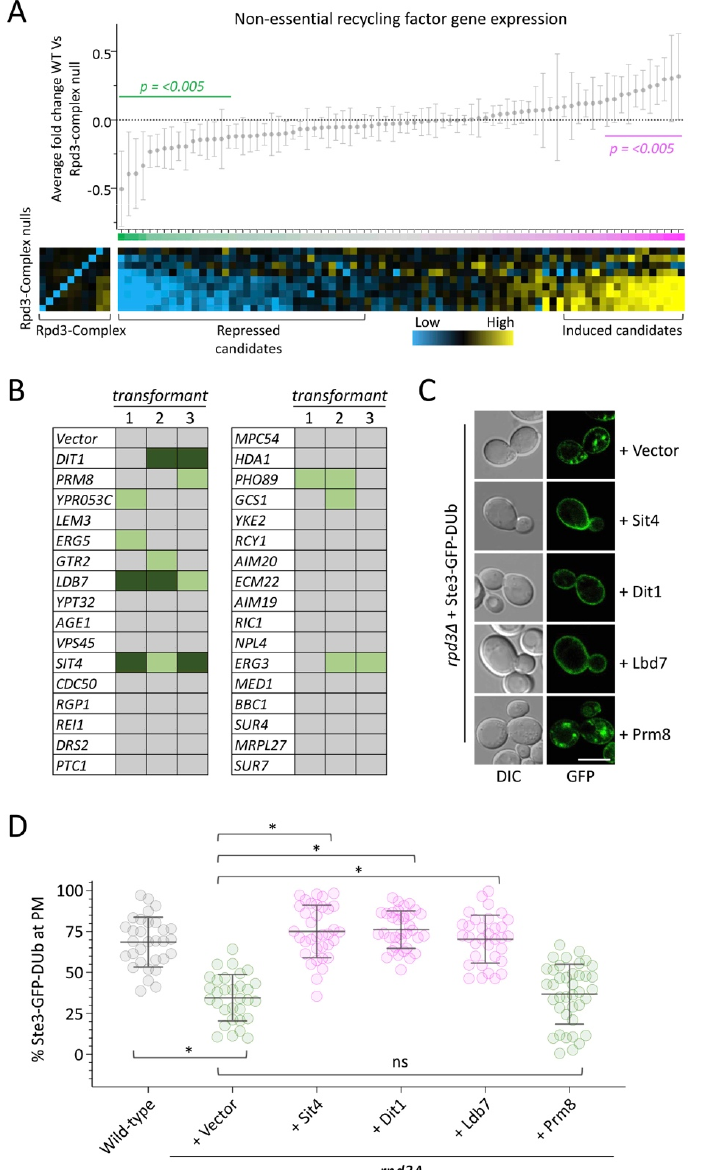
Figure 5. Complementation screen reveals Rpd3 recycling targets. ( A ) Changes in gene expression of 89 validated recycling factors were averaged across various null mutants of the Rpd3-complex compared with wild-type, with mean ± standard deviation plotted (upper). Individual log2 fold-change expression profiles were also assembled (organised rows top—bottom: stb2 ∆ , ume1 ∆ , hos2 ∆ , cti6 ∆ , pho23 ∆ , sap30 ∆ , dep1 ∆ , sin3 ∆ , rpd3 ∆ ) as a heat map (lower right ). The successful deletion of each gene is shown to reduce expression of each individual subunit (lower left ). ( B ) Each of the listed genes were chosen for over-expression in rpd3 ∆ cells stably integrated with Ste3-GFP-DUb. Single colony transformants of each were grown to mid-log phase and imaged by confocal microscopy. Transformants that rescue Ste3-GFP-DUb recycling were first scored qualitatively, with modest (light green) and substantial (dark green) levels of potential complementation of recycling indicated. ( C ) Over-expression candidates identified from the screen described in ( B ) were grown to mid-log phase and prepared for confocal imaging. ( D ) Quantification of % PM Ste3-GFP-DUb in each of the indicated cellular conditions, with asterisks (*) used to indicate significant difference of p < 0.0001 from t -test comparisons. Scale bar, 5 µm.